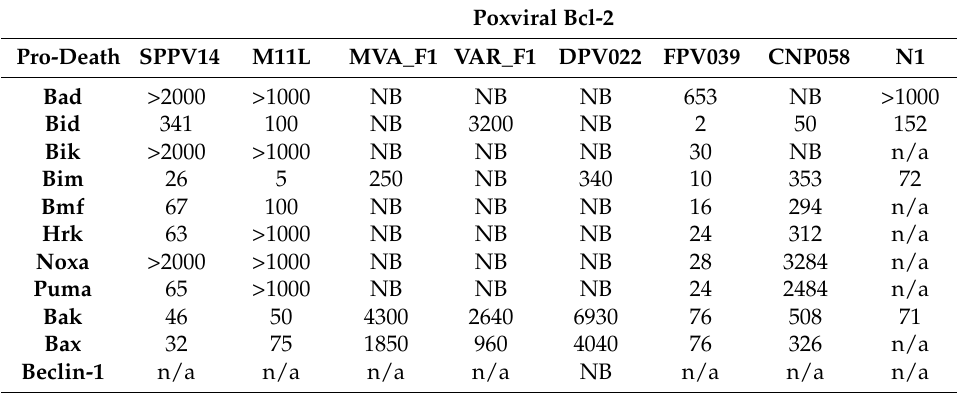
Table 2. Affinities (in nM) of different pro-survival Bcl-2 proteins for peptides spanning the BH3 motif of endogenous pro-apoptotic Bcl-2 family members or Beclin-1 (measurements taken from: [16,18,34,35,37–48]).